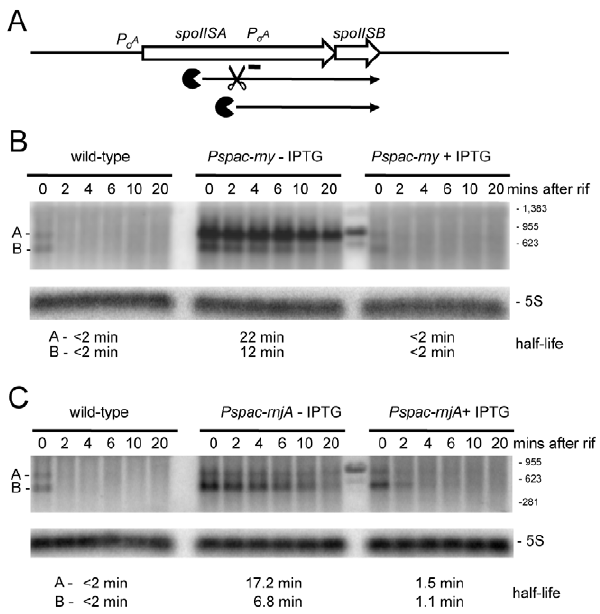
Figure 5. Degradation of the spoIISAB mRNA depends on both RNase Y and J1. (A) Structure and predicted degradation pathway(s) of the spoIISAB transcript. ORFs are shown as large white arrows, transcripts as thin black arrows. Scissors indicate cleavage by RNase Y, ‘Pacman’ symbols represent 5 9 -3 9 degradation by RNase J1. A short thick line indicates the position of the probe used. P s A indicates the approximate promoter position and relevant sigma factor mapped in [26]. (B) Northern blot of total mRNA isolated at times after addition of rifampicin (rif) from wild-type and RNase Y depleted ( Pspac-rny 2 IPTG) and RNase Y induced ( Pspac-rny + IPTG) cells. The blot was probed with 5 9 - labeled oligo CCB826 (Table S6) and reprobed with oligo HP246 against 5S rRNA. The half-lives of the different RNA species (A, B) from the spoIISAB are given under the Northern blot. Migration positions of RNA markers are shown to the right of the blot. Some cross-hybridization to the marker is visible in the lane between the ( 2 ) and ( + ) IPTG samples. (C) Northern blot of total mRNA isolated at times after addition of rifampicin (rif) from wild-type and RNase J1 depleted ( Pspac-rnjA 2 IPTG) and RNase J1 induced ( Pspac-rnjA + IPTG) cells. Description as in panel (B).